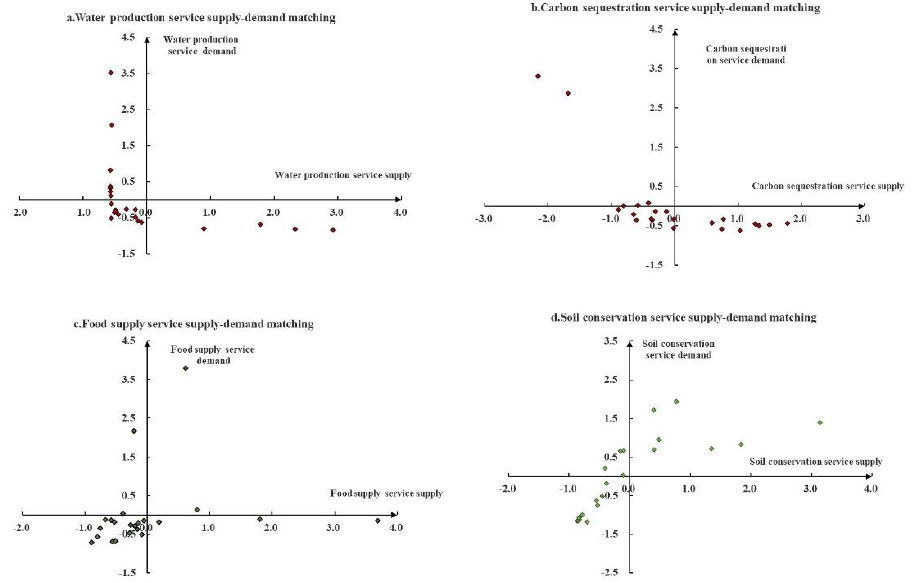
Figure 4. Supply-demand quadrant chart of ( a ) water production service, ( b ) carbon sequestration service, ( c ) food supply service, and ( d ) soil conservation service in the ZKL urban agglomeration.